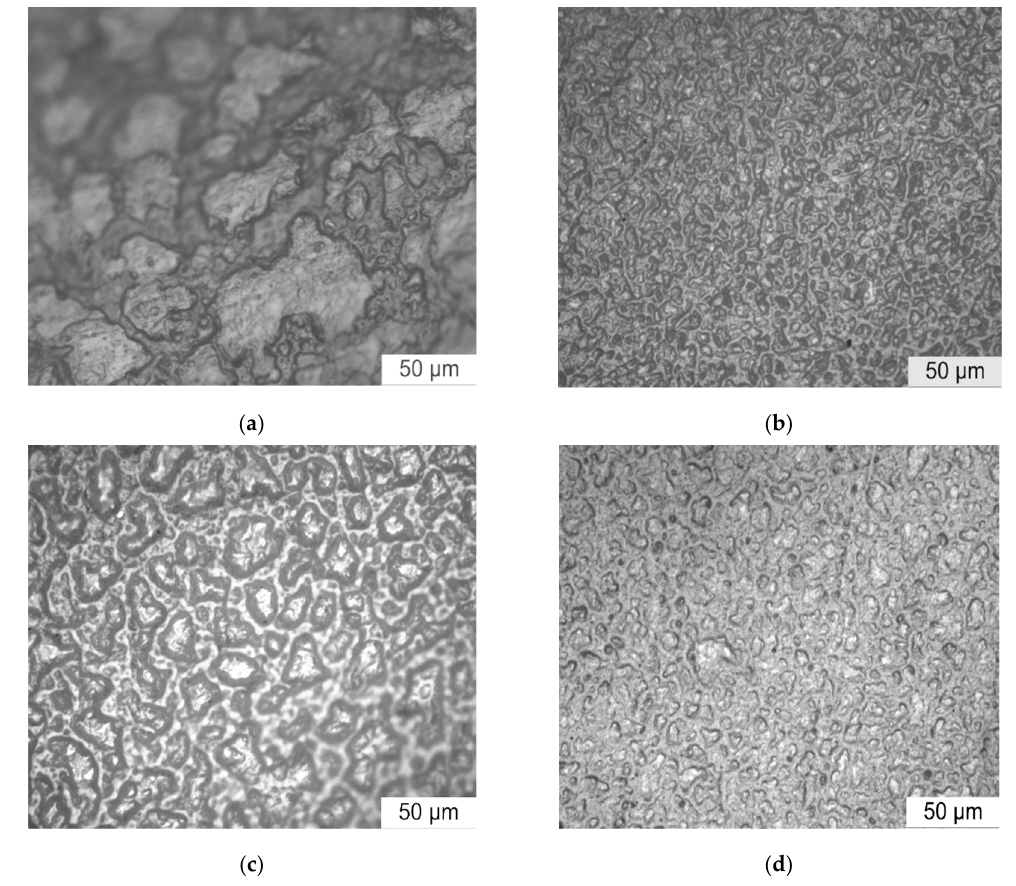
Figure 11. Corona corrosion of ( a ) LDPE; ( b ) N5; ( c ) M5; ( d ) N3M2.